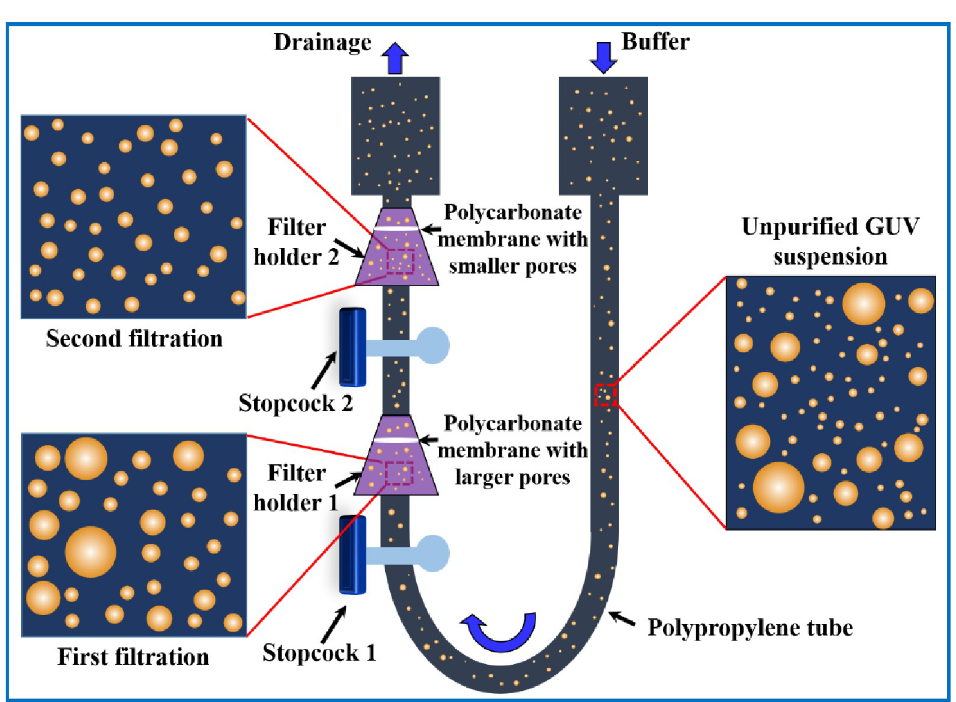
Fig 3. A schematic representation of experimental set-up of dual filtration.